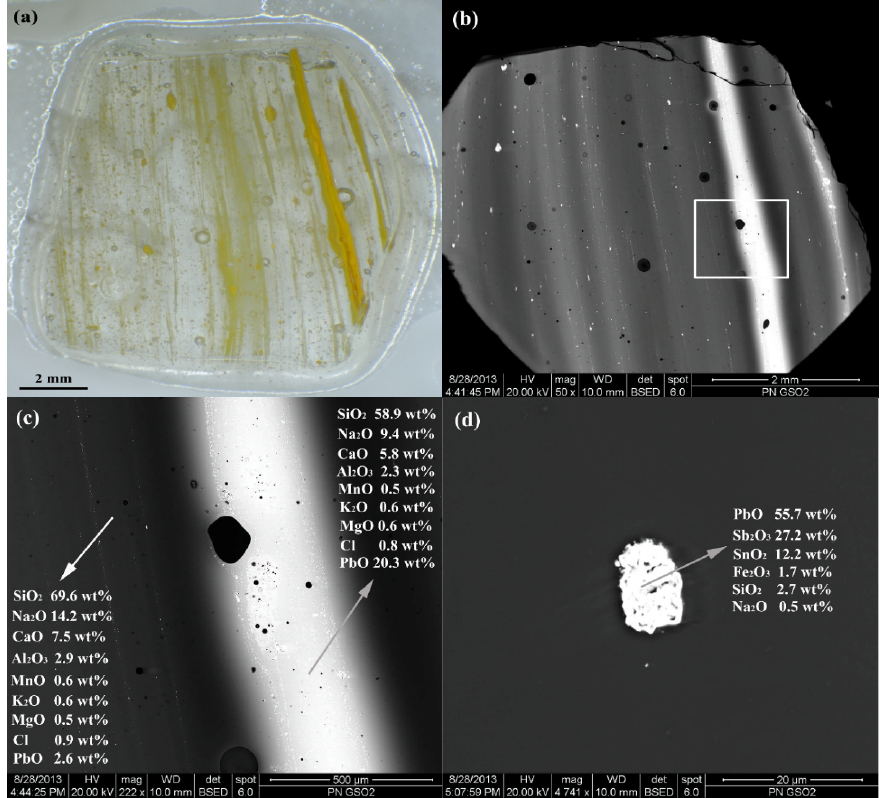
Figure 8. OM ( a ) and SEM-BSE ( b – d ) images of tessera PN GSO2, opacified with Pb-antimonate. Note banding ( a – c ), and anhedral habit of Pb-antimonate ( d ). Chemical compositions of bands and opacifier also reported in ( c ) and ( d ), respectively (SEM-EDS data). Black inclusions in ( c ) are quartz grains.